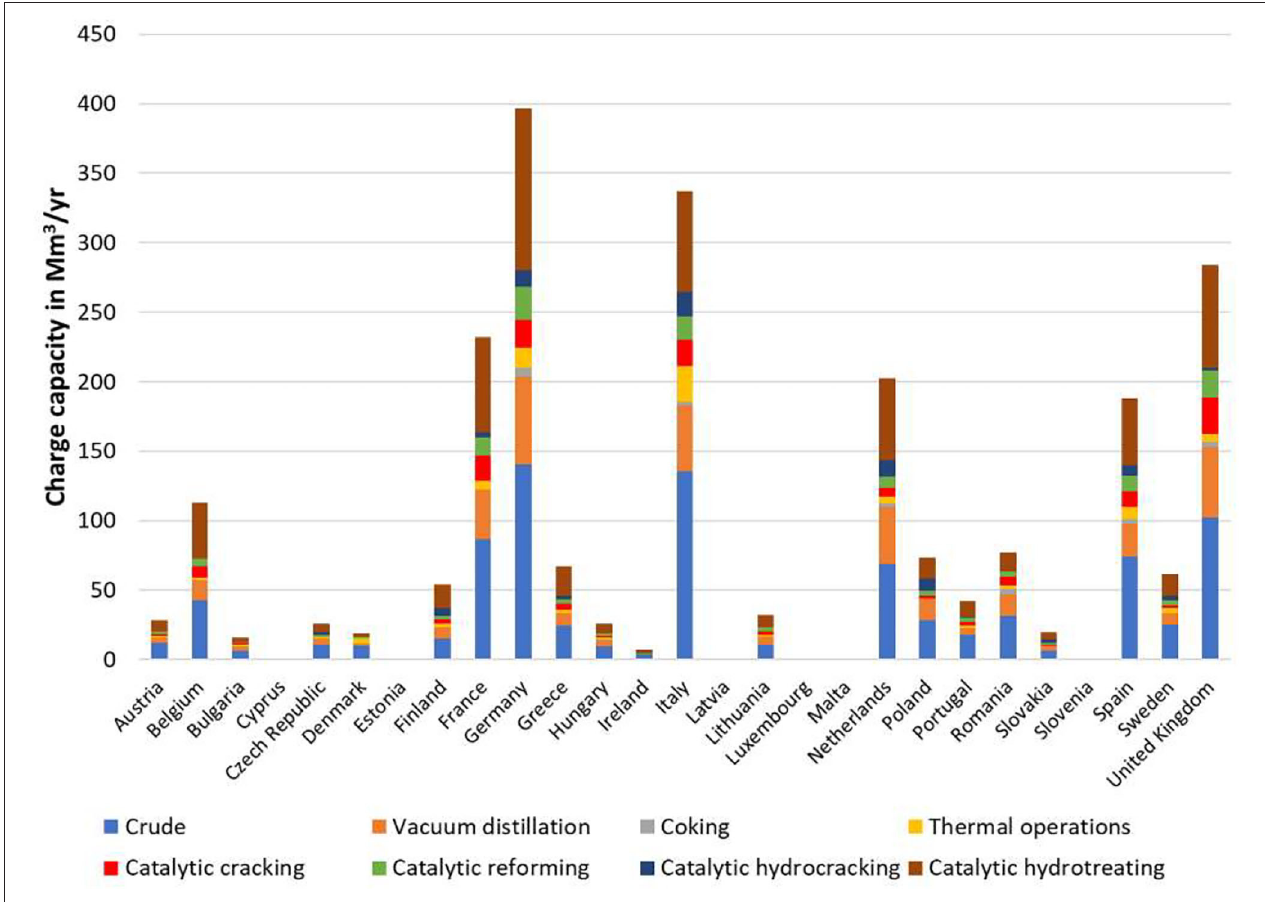
FIGURE 3 | EU 27 capacity for mineral oil refining (source: Barthe et al., 2015).